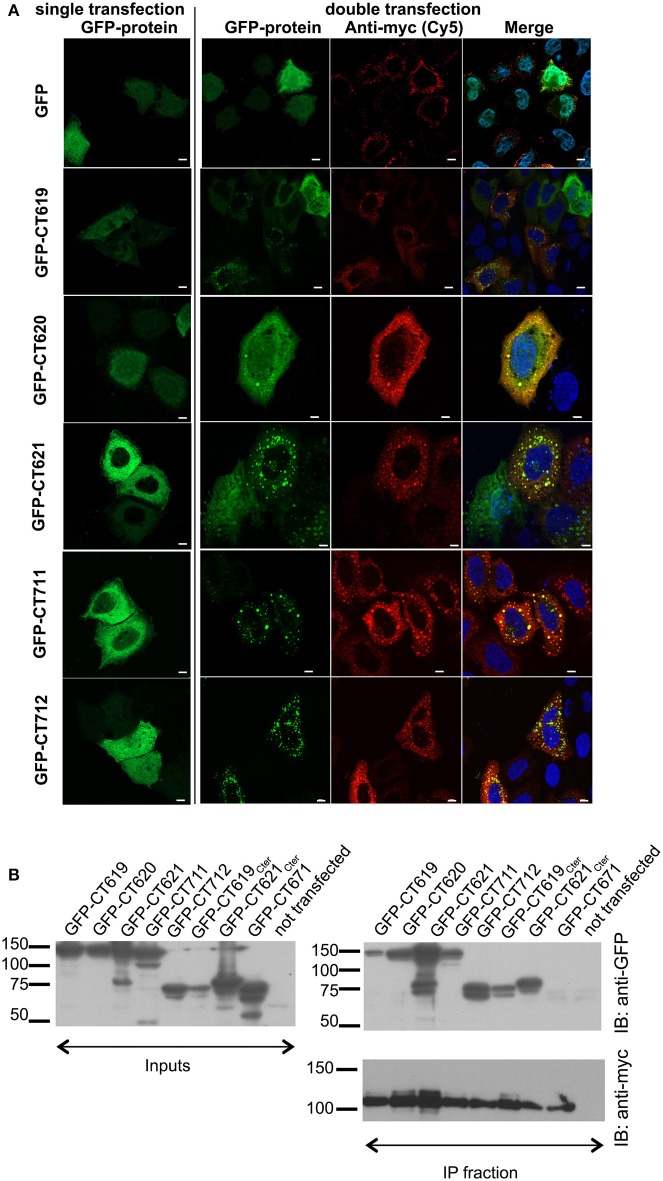
Interaction between the DUF582 and Hrs probed by co-expression in mammalian cells. (A) HeLa cells were transfected to express GFP alone or GFP-tagged DUF582 proteins, either alone (left) or together with myc-Hrs (right). One day later, the cells were fixed in 4% PFA and stained with rabbit anti-myc antibody, followed with a secondary Cy5-conjugated anti-rabbit antibody. DNA, labeled in blue, is shown on the merged picture. Scale bar = 10 μm. (B) HEK-293 cells were transfected with myc-Hrs and the indicated construct for 24 h, lysed and immunoprecipitated with anti-myc antibody. Proteins were separated on SDS-PAGE, transferred on a PVDF membrane and probed with the indicated antibody. An aliquot of each cell lysate was loaded on a separate gel to compare the expression level of each of the GFP-tagged proteins (input) and an aliquot of the immunoprecipitated fraction was loaded on a separate gel to assess the efficiency of the immunoprecipiation using anti-myc antibodies. IB, immunoblot; IP, immunoprecipitation.